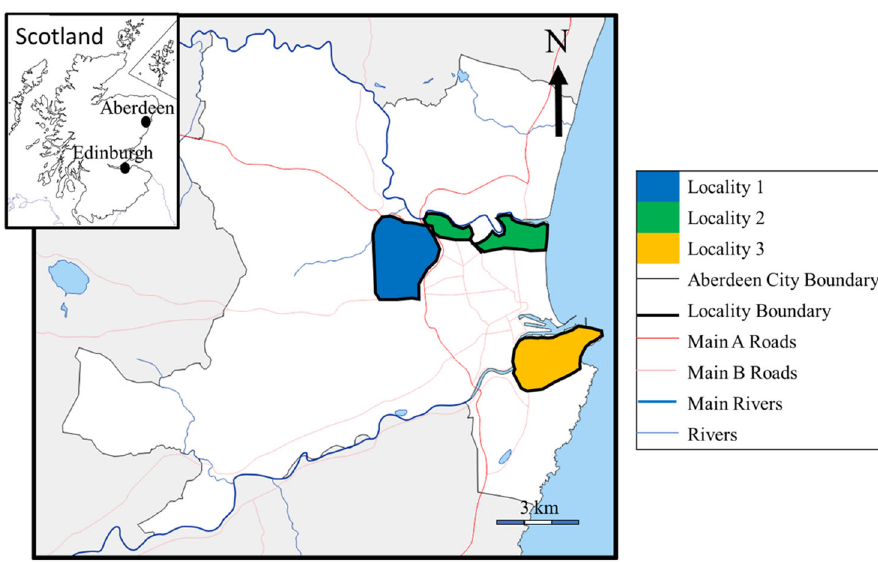
Fig. 1 Map showing